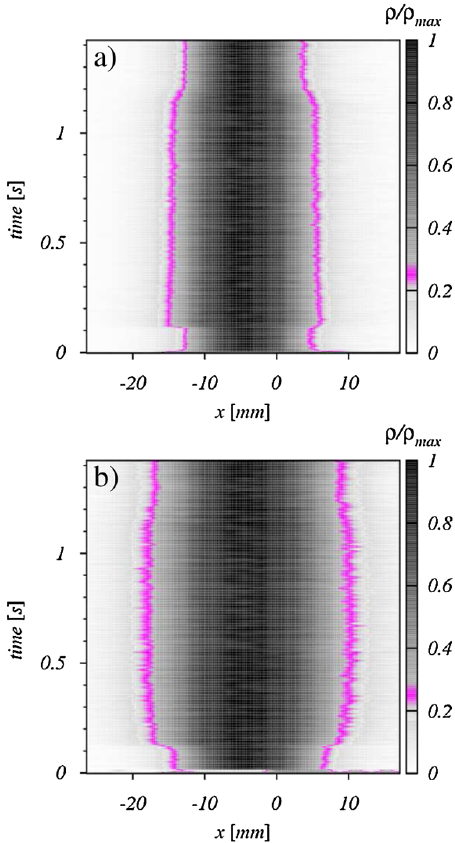
FIG. 16. High intensity bunched beam: Beam profile after injection and at the end of the storage time for Q x ¼ 4 : 3425 , : 245 Q y ¼ 3